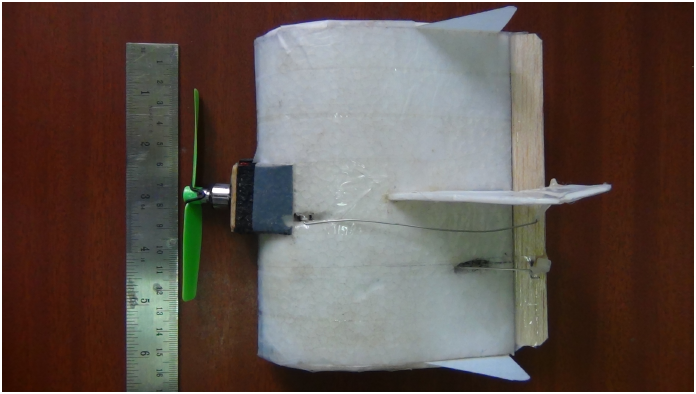
Figure 1. 150 mm wingspan